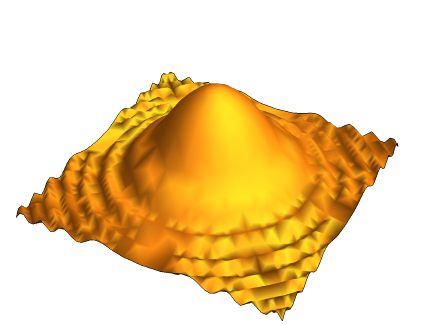
Figure 5: In ordinary local quantum field theories we can specify some feature in the wavefunction inside a bounded region (depicted by the bump) without affecting the wavefunction outside. But, in gravity, not only is one forced to modify the wavefunc- tion outside the region (shown by the wiggles), the constraints are so strong that the detailed wavefunction outside completely fixes it